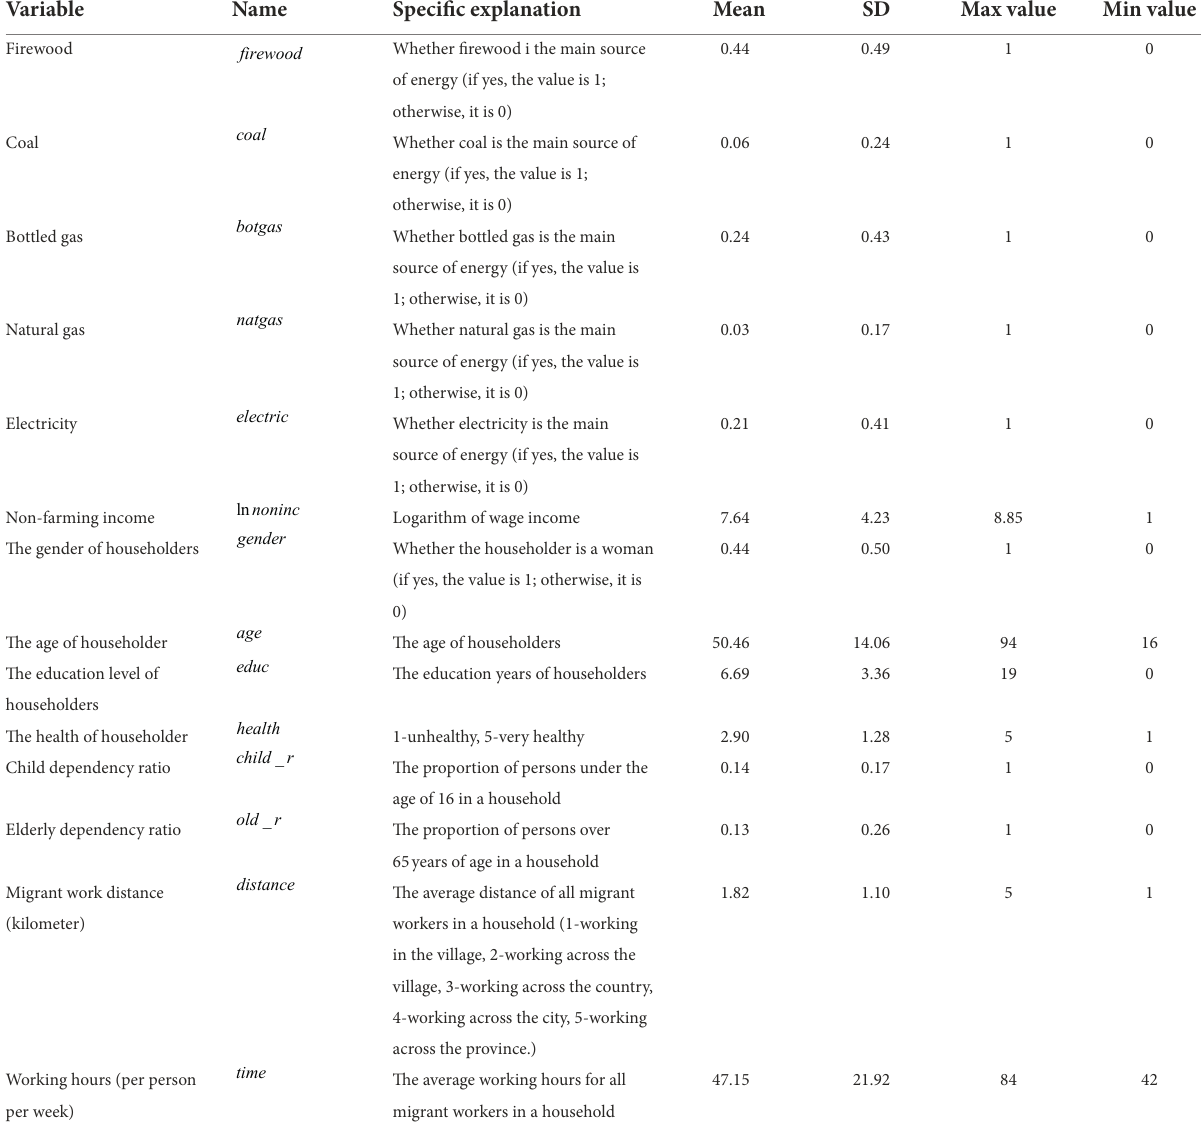
TABLE 1 Statistical description of main variables ( n =